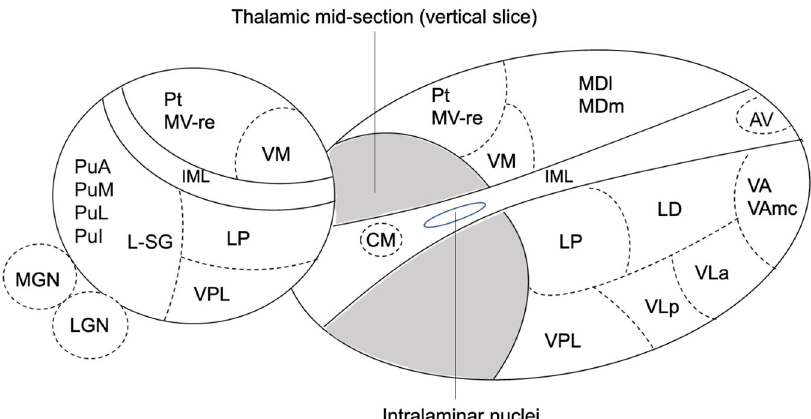
Fig. 2 Three-dimensional schematic representation of thalamic subnuclei. The thalamus is divided into two by a vertical slice to reveal the medial surface. Abbreviations: Anterior nuclei (AV anteroventral); Lateral nuclei (LD laterodorsal, LP lateral posterior); Ventral nuclei (VA ventral anterior,VAmc ventral anterior magnocellular, VLa ventral lateral anterior, VLp ventral lateral posterior, VPL ventral posterolateral, VM ventromedial; Intralaminar nuclei (CM centromedian, CeM central medial, CL central lateral, Pc paracentral, Pf parafascicular);Medial nuclei (Pt paratenial, MV-re reuniens (medial ventral), MDm mediodorsal medial magnocellular, MDl mediodorsal lateral parvocellular); Posterior nuclei (LGN lateral geniculate nucleus, MGN medical geniculate nucleus, L-SG limitans (suprageniculate), PuA pulvinar anterior, PuM pulvinar medial, PuL pulvinar lateral, PuI pulvinar inferior); IML Internal medullary